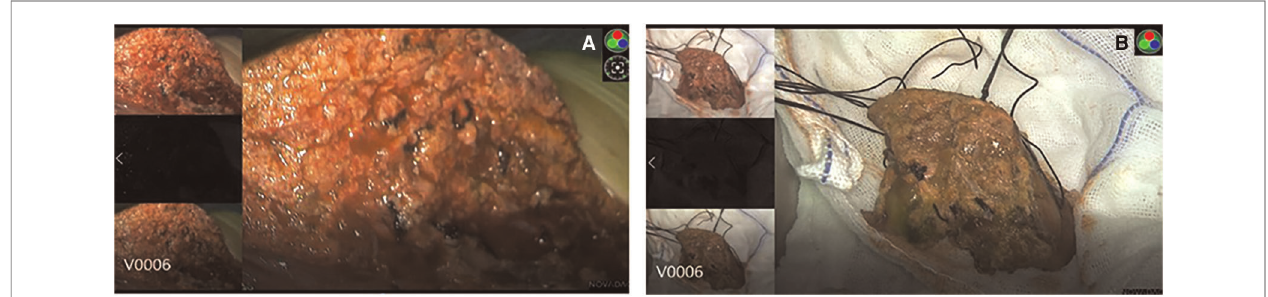
FIGURE 4 | No fl uorescence was detected at the liver resection plane in situ ( A ) and ex vivo (